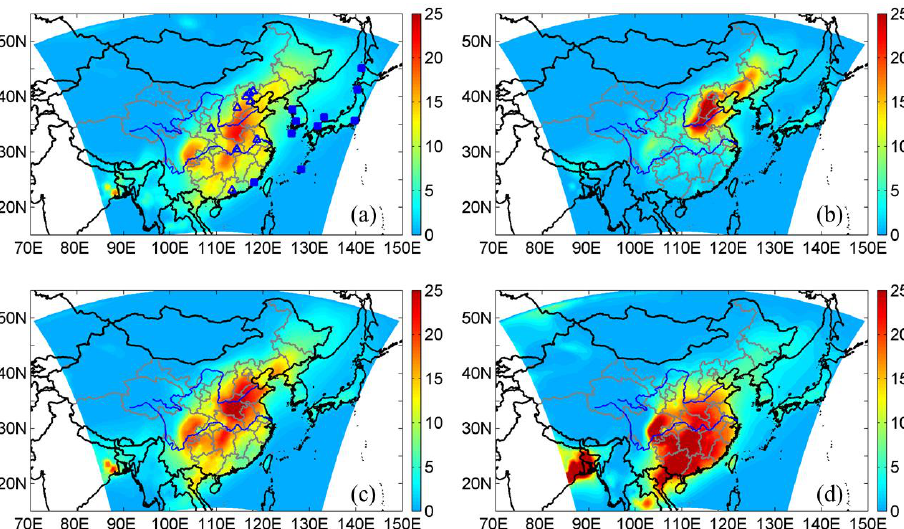
Figure 2. Seasonal mean surface nitrate concentrations (μg·m −3 ) from simulation for ( a ) spring; ( b ) summer; ( c ) autumn; and ( d ) winter in 2010. Observation sites including ten EANET sites (solid blue squares) and eight Chinese sites (open blue triangles) are marked and their locations refer to Tables 1 and 2, respectively.